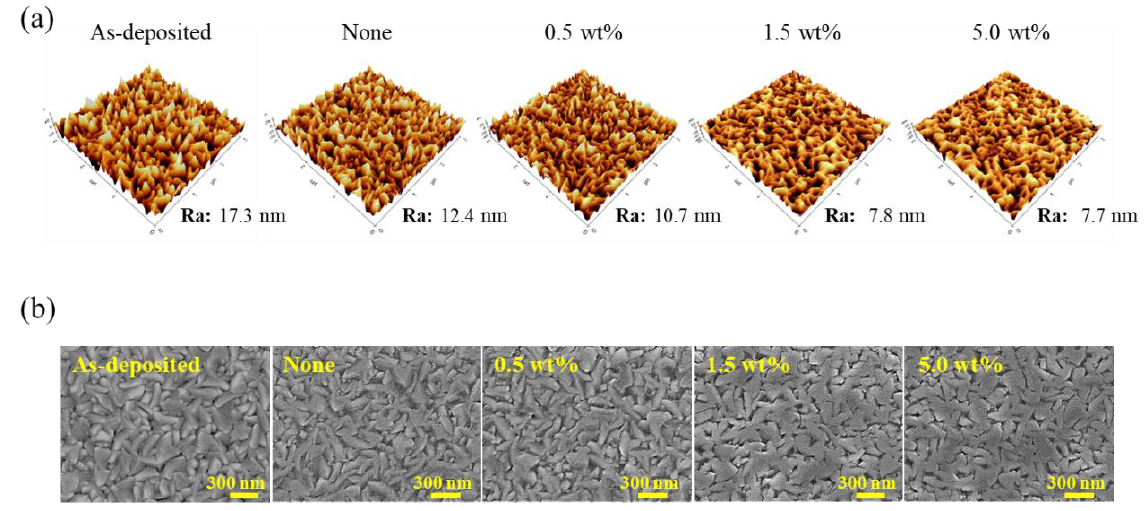
Figure 3. ( a ) Atomic force microscopy (AFM) and ( b ) scanning electron microscope (SEM) images of tungsten films after the CMP evaluation as a function of picolinic acid concentration.